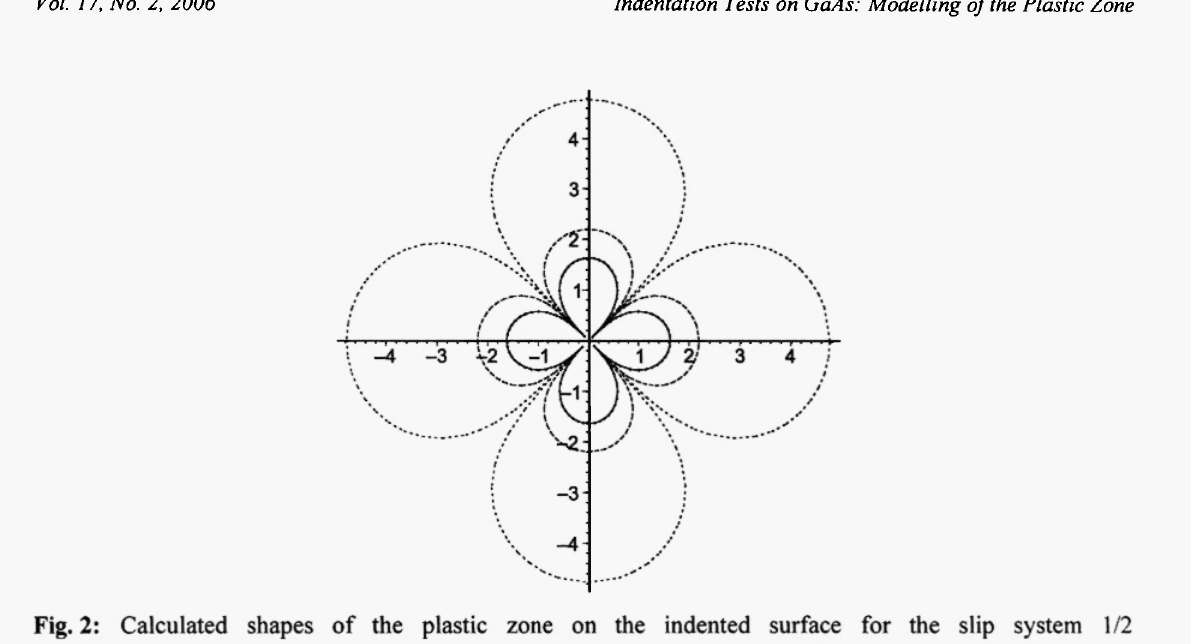
[110](111). The largest zone is that of Hill (dash-dotted line) followed by blister field (dashed line), Boussinesq (solid line) and Mindlin (points) stress tensors lead to the same result. Dimensions are in micrometers.